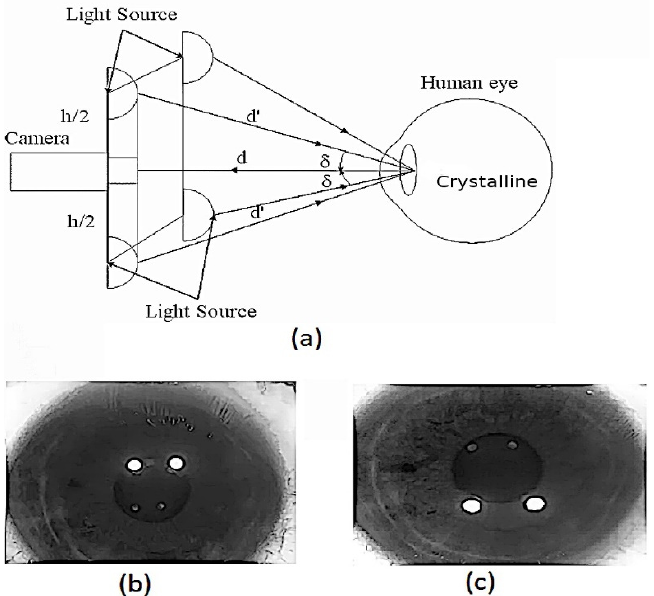
Figure 5. Schematic representation of a prototype setup for Purkinje IV reflection pattern evaluation with light sources pointing at the eyes from above. ( a ) The light sources are separated by the distance, h and h , from the camera. In this setup, 𝑑 and 𝑑′ form an angle 𝛿 that allows us to see the Purkinje images (PI and PIV). ( b ) Results obtained when used to impinge on the light source placed on top. ( c ) Results obtained when used to impinge on the light source placed below.